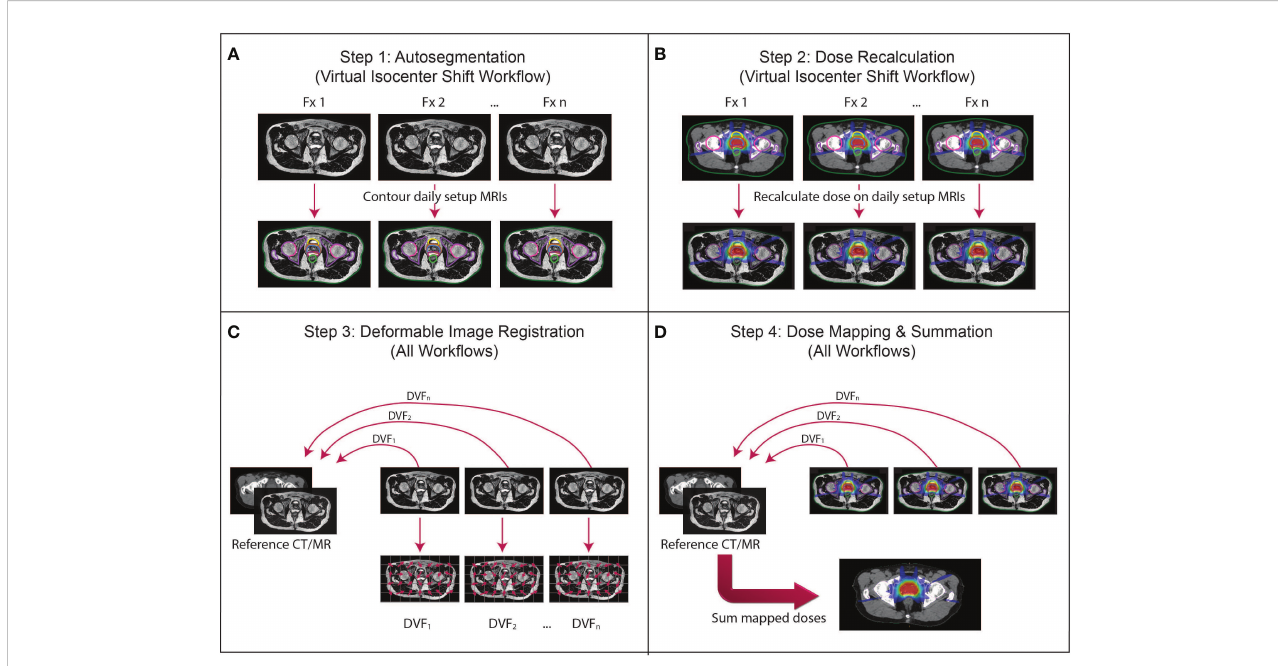
FIGURE 1 The proposed dose accumulation framework for MRgART. (A) Step 1 (virtual isocenter shift work fl ow only): Because the virtual isocenter shift work fl ow calculates dose on the reference image rather than the daily setup MRI, the daily images are not contoured during the treatment and must be segmented off-line. (B) Step 2 (virtual isocenter shift work fl ow only): The doses for each fraction must be recalculated on the daily setup images off-line to reconstruct the delivered dose at each fraction. (C) Step 3 (all work fl ows): The geometric correspondence between each daily image and the reference image set (i.e. simulation or any other established time point) is created via deformable image registration (DIR) and represented by a deformation vector fi eld (DVF). (D) Step 4 (all work fl ows): The DVFs are applied to the corresponding dose distributions to map the doses onto